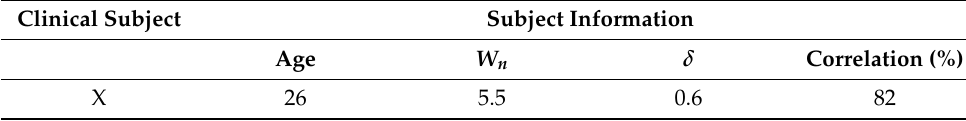
Table 4. Controller parameter for simulation.